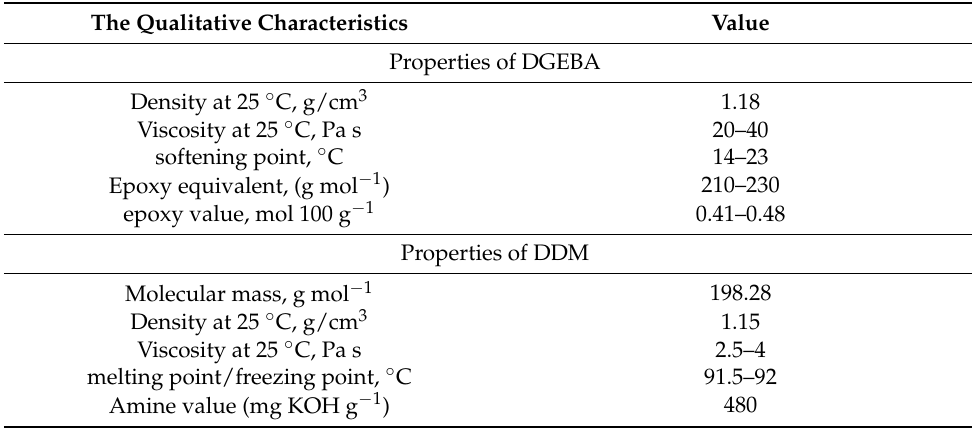
Table 1. The typical properties and specifications of DGEBA and DDM.